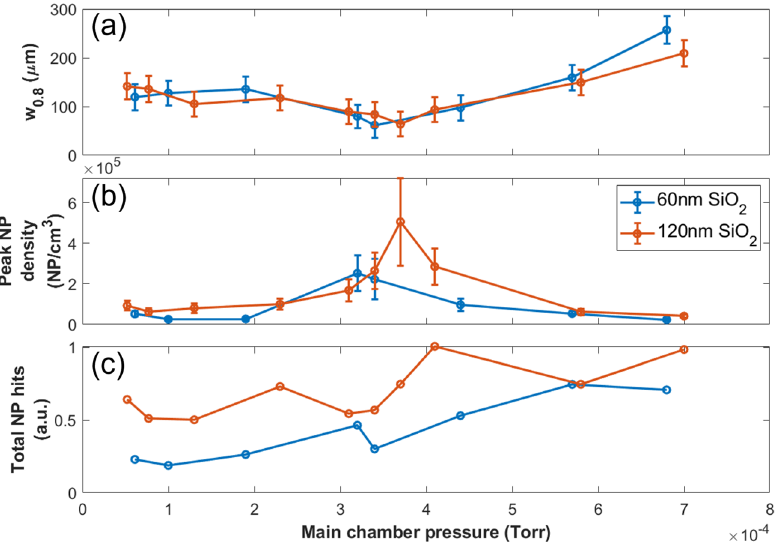
Figure 4. 60 nm and 120 nm SiO 2 NP beams: ( a ) w 0.8 , ( b ) peak density, and ( c ) total NP hits as a function of gas flow into the aerodynamics lens as controlled by the pinch bolt (depicted in Figure 1) and monitored by the pressure in the interaction chamber. Error bars in ( a ) represent the step size of the motorized mirror, whereas those in ( b ) additionally account for the uncertainty in the focal spot size